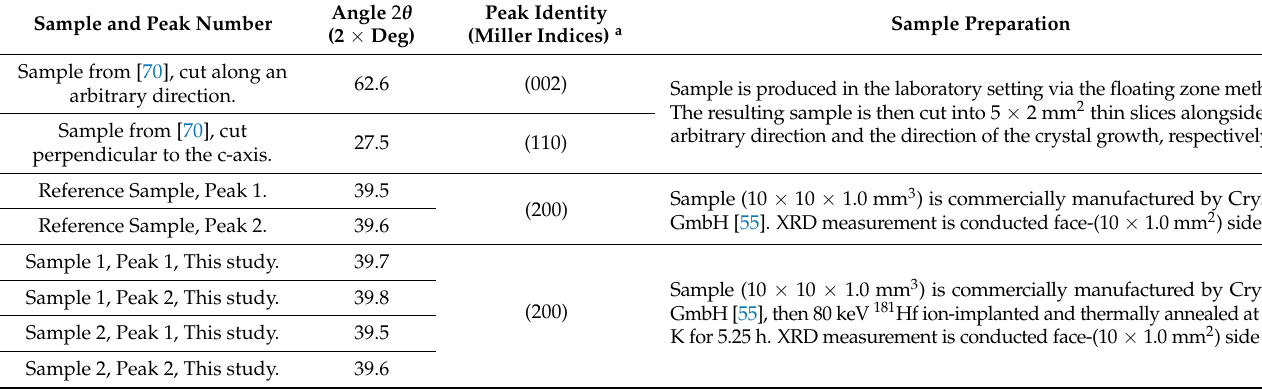
Table 5. An XRD comparison of the 2 dominant peaks of our single crystal rutile TiO 2 samples to the (1) reference sample produced by Crystal GmbH [55] and (2) the samples produced via the floating zone method as described in the paper of Guo et al. [70]. We note that in their corresponding XRD diffractogram (Figure 2 of [70]), regardless of the direction of the cut, we could see multiple small peaks that are too fine to be distinguished with their domain of 20–50 ◦ , like our case as seen in Figure 8, in which we must restrict our domain from 0–80 ◦ to 38–40 ◦ to allow for sufficient resolution. (a) The peak identification of the Miller indices for our samples (and the reference sample) concerns reference [72]. For samples from paper [70], the peaks are already identified in the corresponding paper and cross-verified with reference [72].